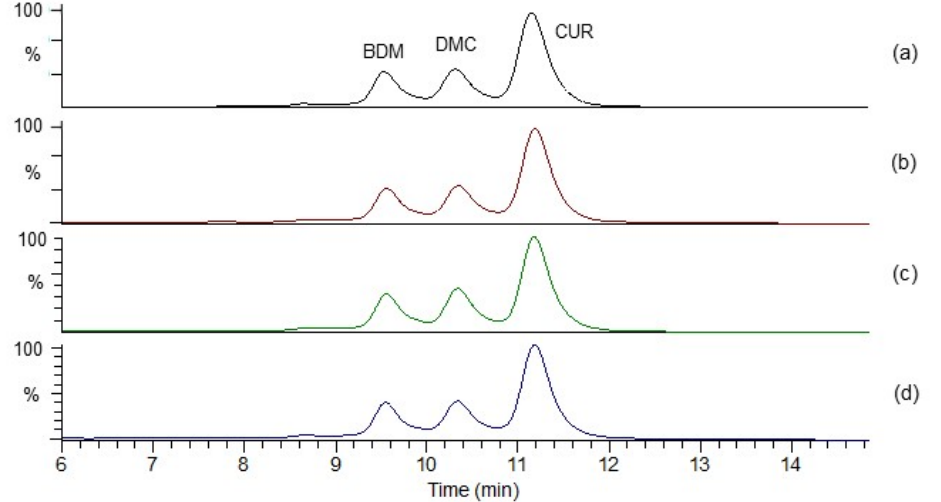
Figure 13. UPLC-DAD chromatograms for samples: ( a ) NE-1, ( b ) NR-1, ( c ) NW-1 and ( d ) WR-1,